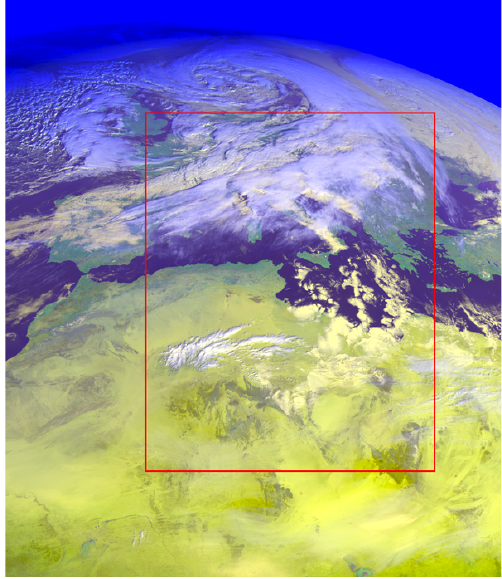
Fig. 7. RGB false colour composite of the area (in red) from SEVIRI corresponding to the comparisons in Figs. 6, 9, 10 and F11. Date and time: 1 January 2007, 10:00UTC.